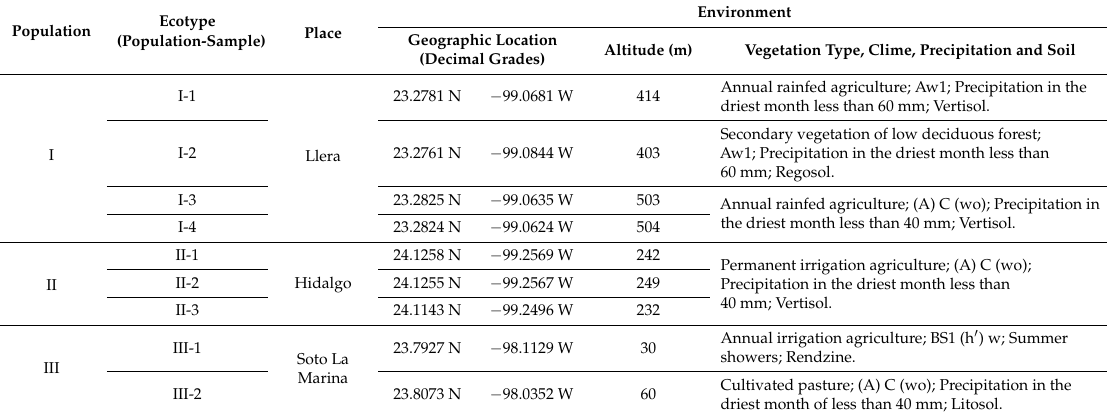
Table 4. Origin and environment of wild populations of C. annuum var. glabriusculum from Tamaulipas,